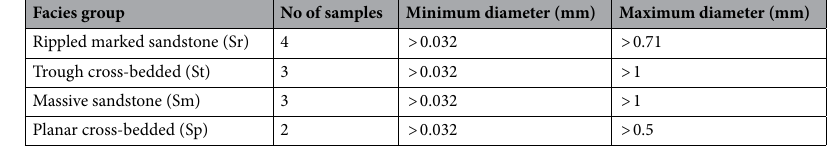
Table 5. Statistical data of the analyzed samples grouped according to their facies types and